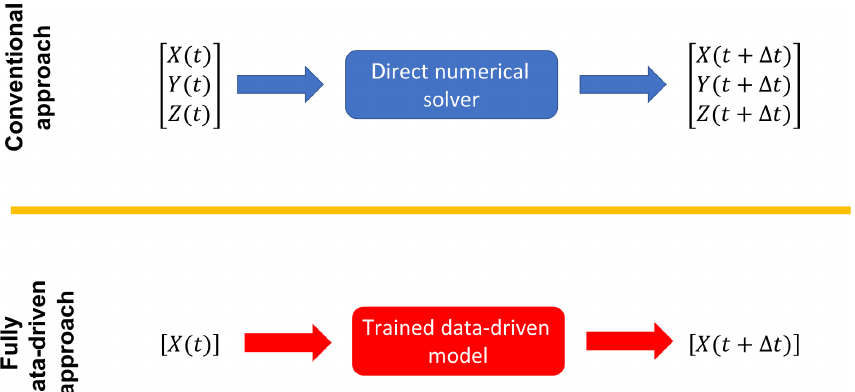
Figure 2. The conventional approach of solving the full governing equations numerically versus our data-driven approach for predicting the spatiotemporal evolution of the slow/large-scale variable X . For the direct numerical solution, the governing equations have to be known and the numerical resolution is dictated by the fast and small-scale variable Z , resulting in high computational costs. In the data-driven approach, the governing equations do not have to be known, Y and Z do not have to be known, and evolution of X is predicted just from knowing the past observations of X , leading to low computational